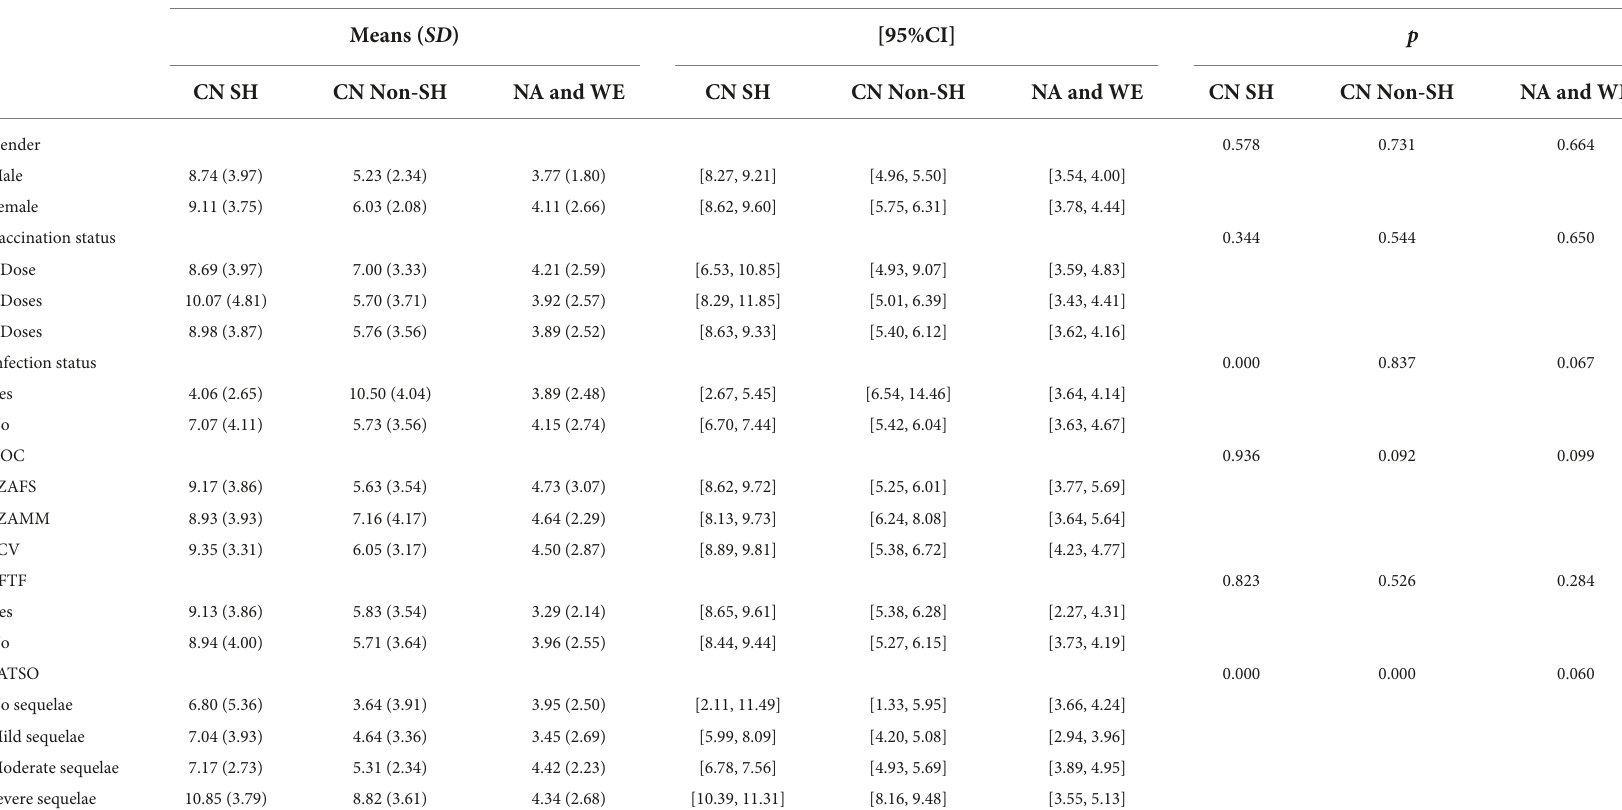
TABLE 2 General anxiety disorder 7-item (GAD-7) scores of participants ( N = 1,500).